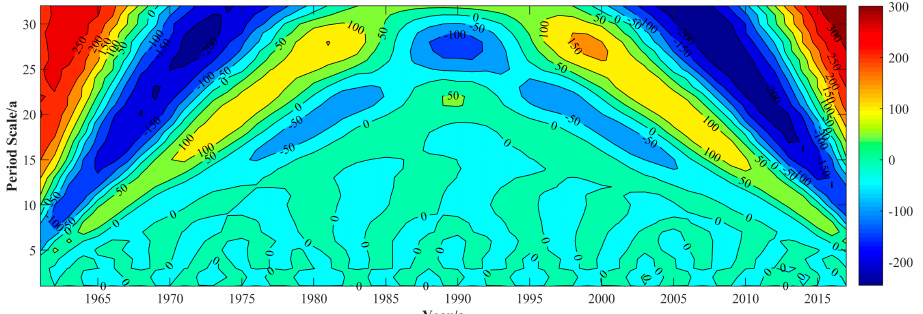
Figure 10. Contour map of the real part of wavelet coe ffi